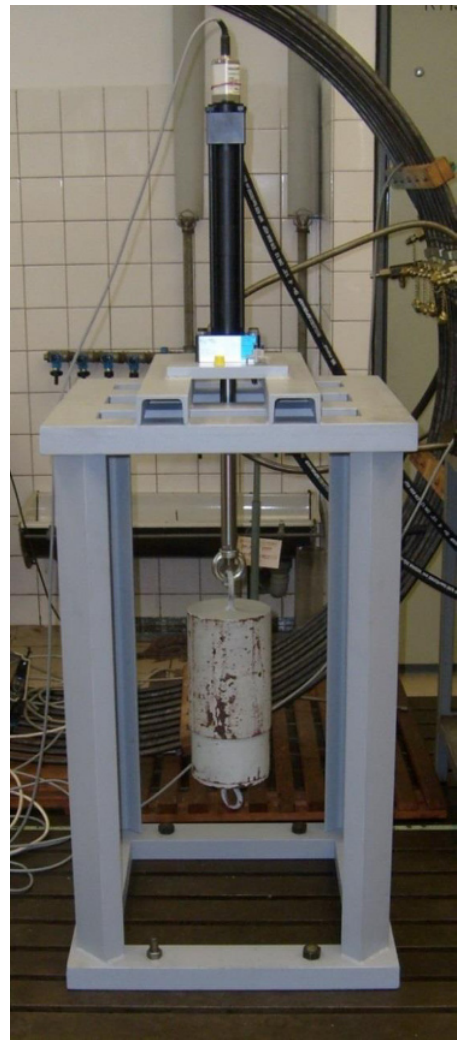
Fig. 2. Detailed description of the lines HL A and HL B . Fig. 3. Experimental equipment